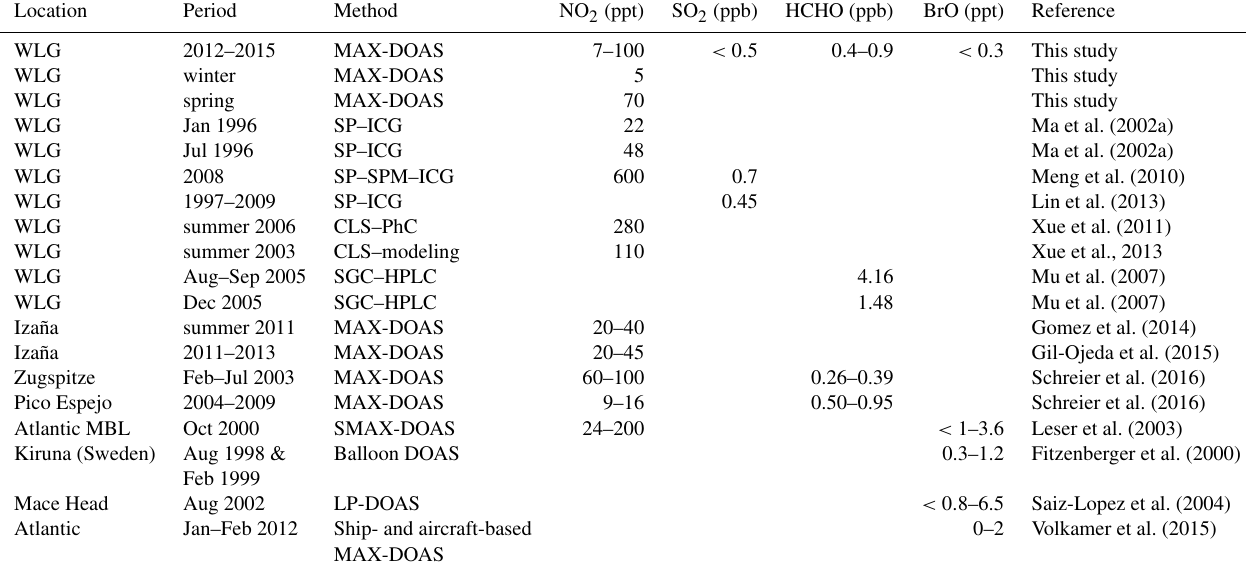
Table 2. Comparisons between trace gas mixing ratios at WLG and those recorded in other remote areas at low latitudes.